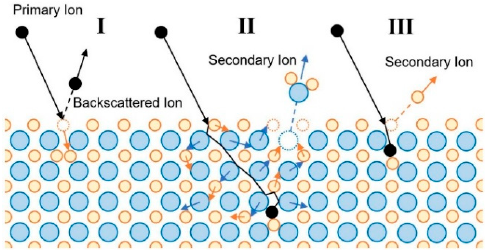
Figure 2. The diagram of the production of the backscattered ions (I) and the secondary ions (II and III). The secondary ions include fragment ions (II) and simple ions (III).